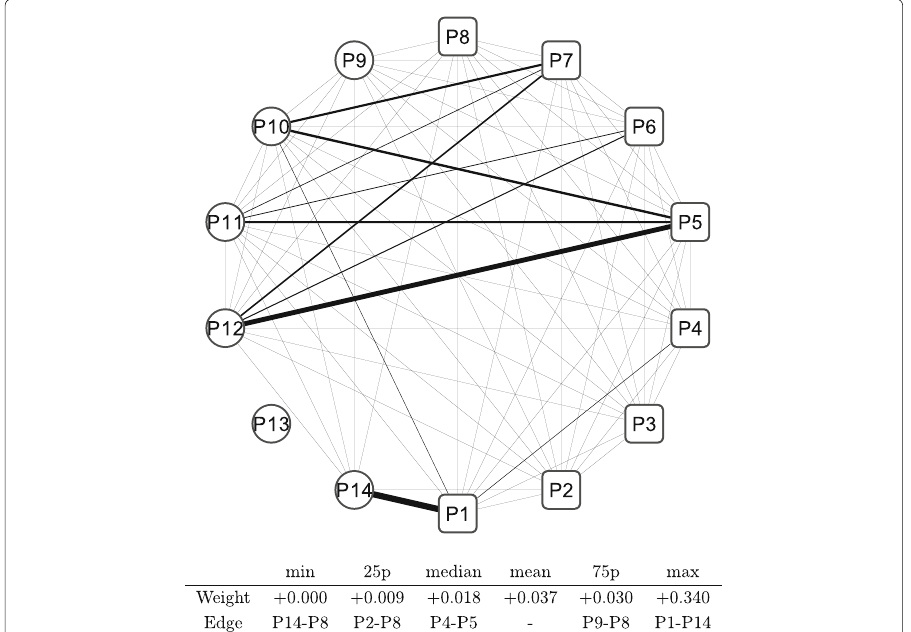
Fig. 16 Changes in network between sub-periods: T3–T1. Note: The network shows the difference between the sub-period T3 and T1. The edge weight (the edge width) is calculated by subtracting elements of the adjacency matrix of T1 from those of T3 described as T3 − T1. Only the edges that have positive weights (T3 > T1) are shown. The bottom table shows the quantiles of edge weights distribution with corresponding